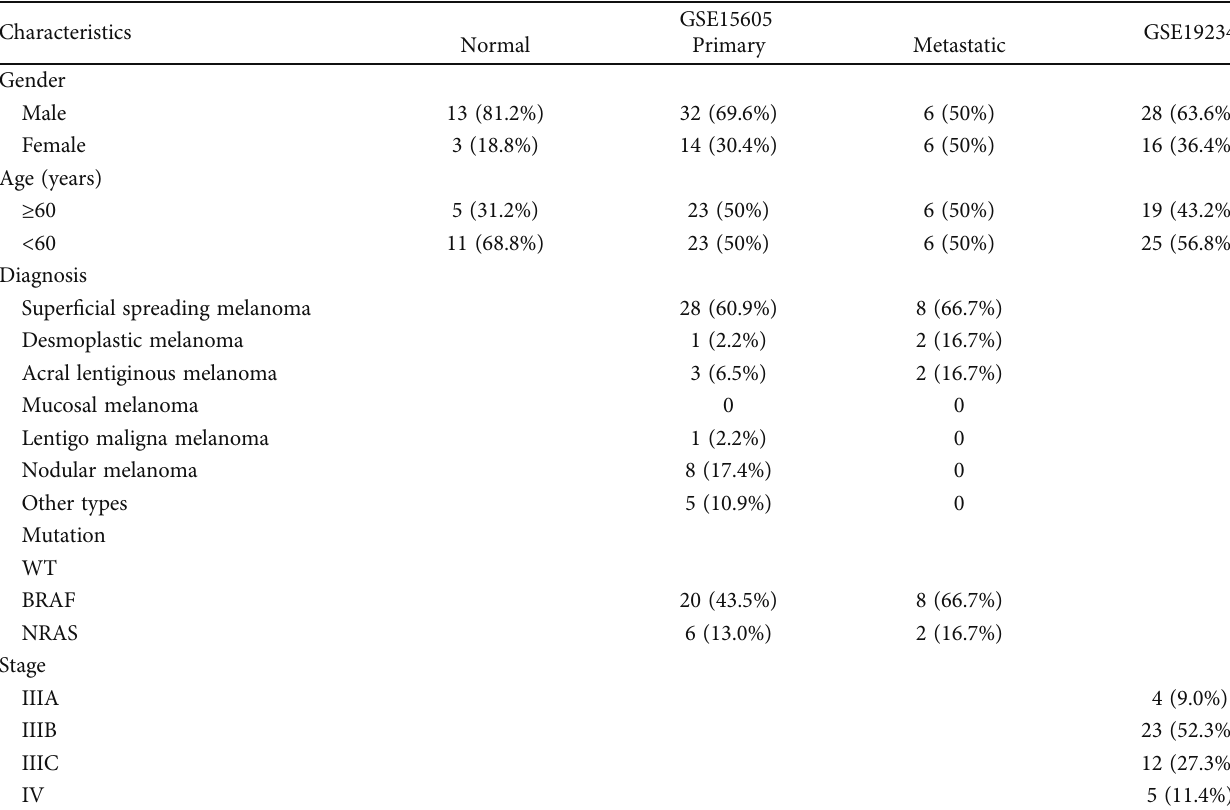
Table 2: Clinicopathologic parameters of patients with malignant melanoma from the datasets GSE15605 and GSE19234.